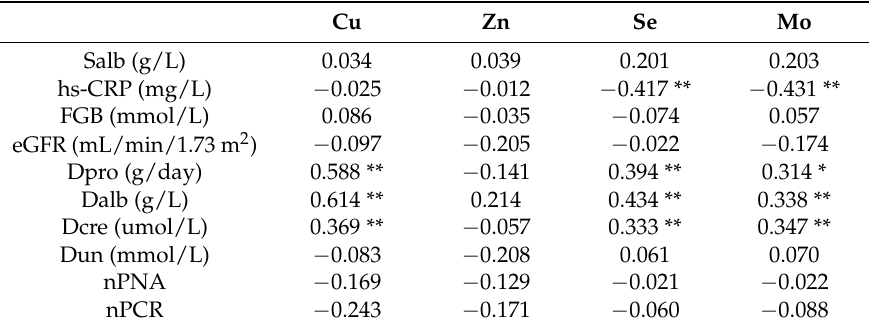
Table 4. Spearman correlation coefficients between study variables and trace element excretions in dialysate per